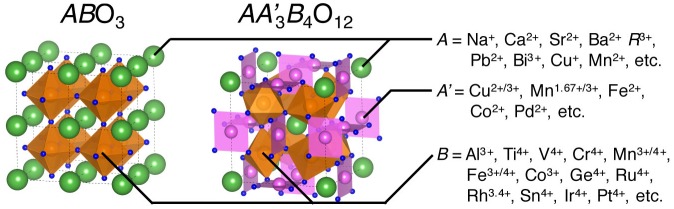
Crystal structure of simple (ABO3-type) and quadruple (AA′3
B
4O12-type) perovskites.